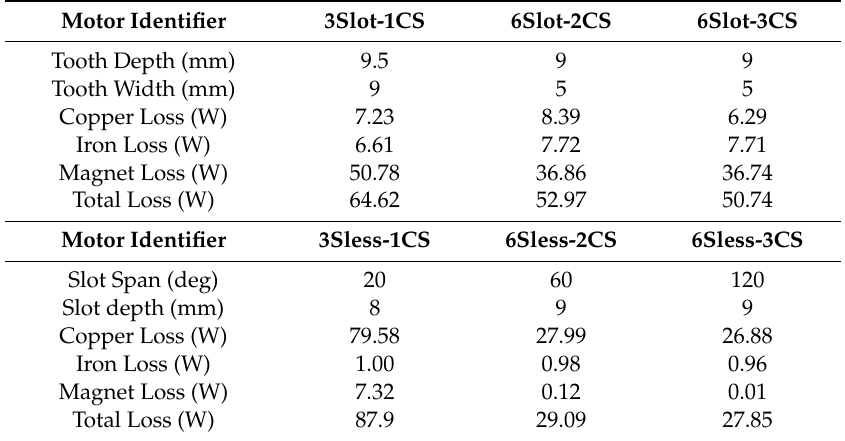
Figure 9. Stator geometric design for the total loss minimization: ( a ) 3Slot-1CS, ( b ) 6Slot-3CS, ( c ) 3Sless-1CS, and ( d ) 6Sless-3CS (copper sleeve, 1 p.u. torque and rated speed 80 krpm). Table 6. Di ff erent loss components of six di ff erent motors with